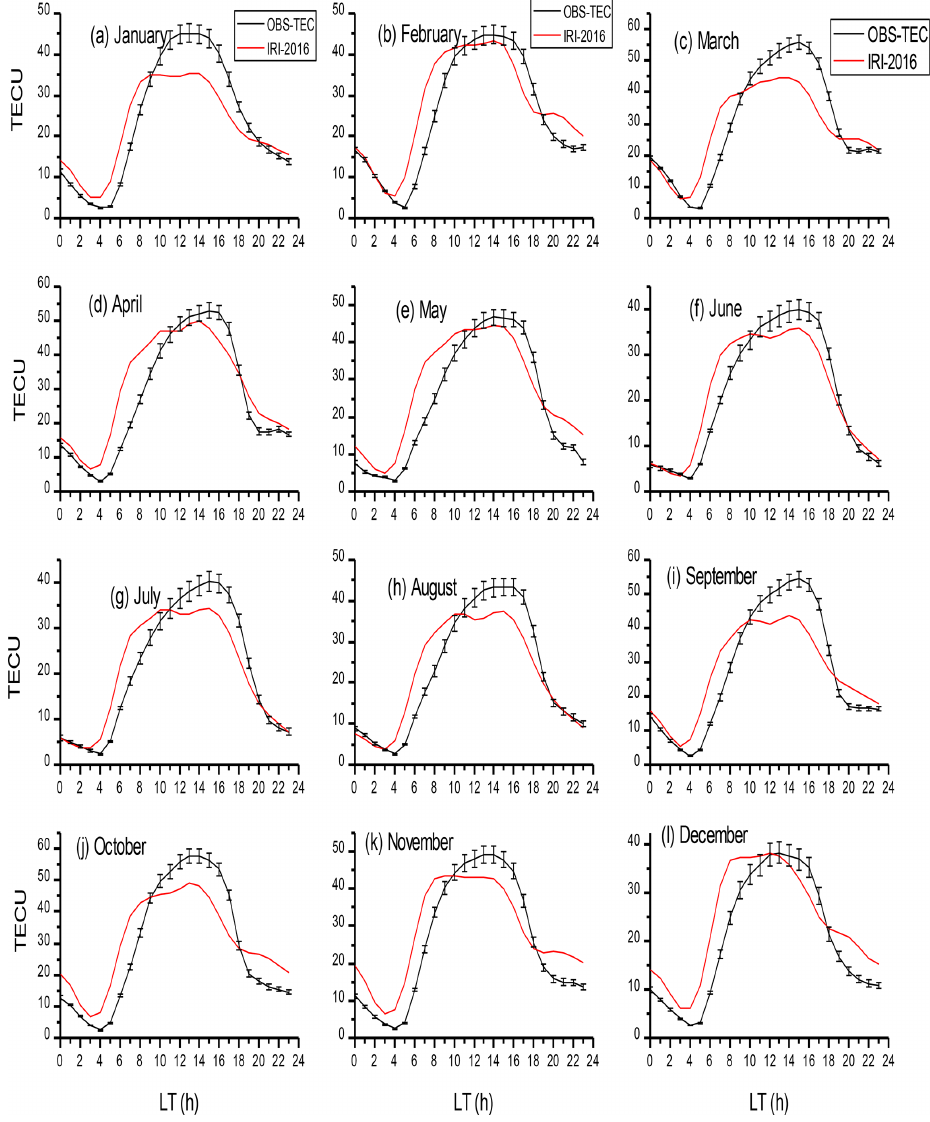
Figure 2. Same as Fig. 1 but for